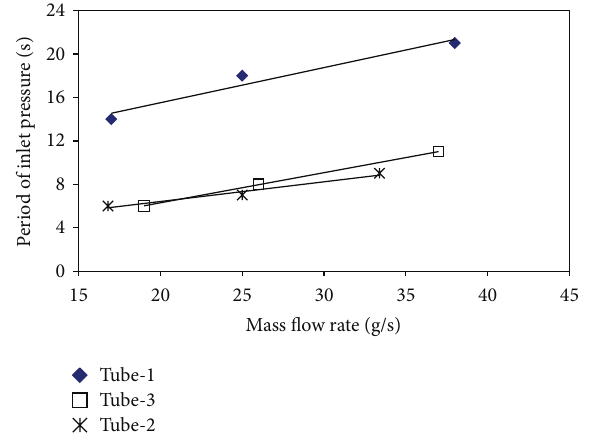
F 17: e variations of the periods with the mass �ow rate for all tubes (d. w. o.).